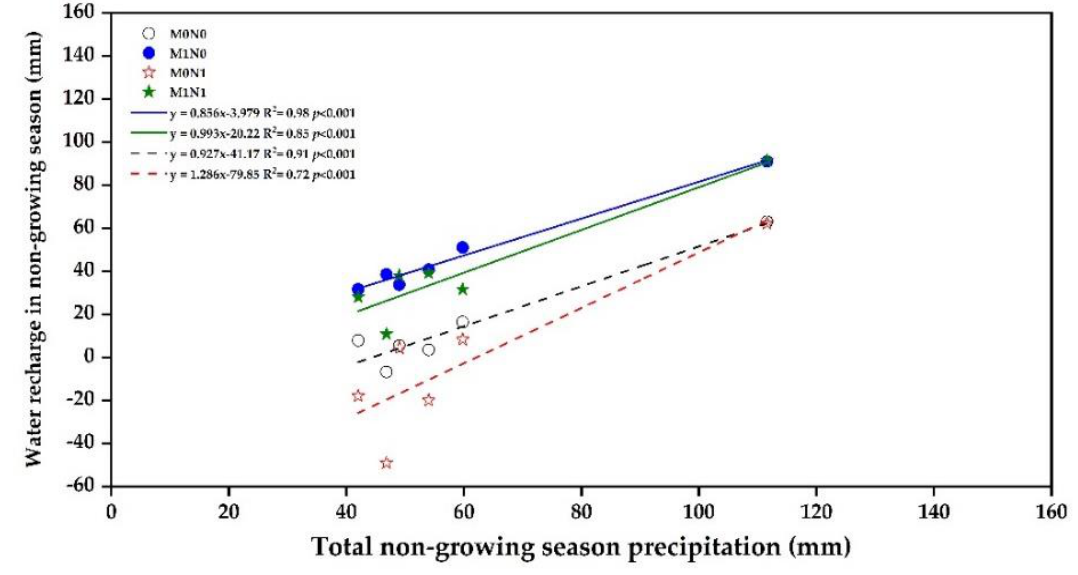
Figure 6. Linear relationship between precipitation and water recharge in the nongrowing season.